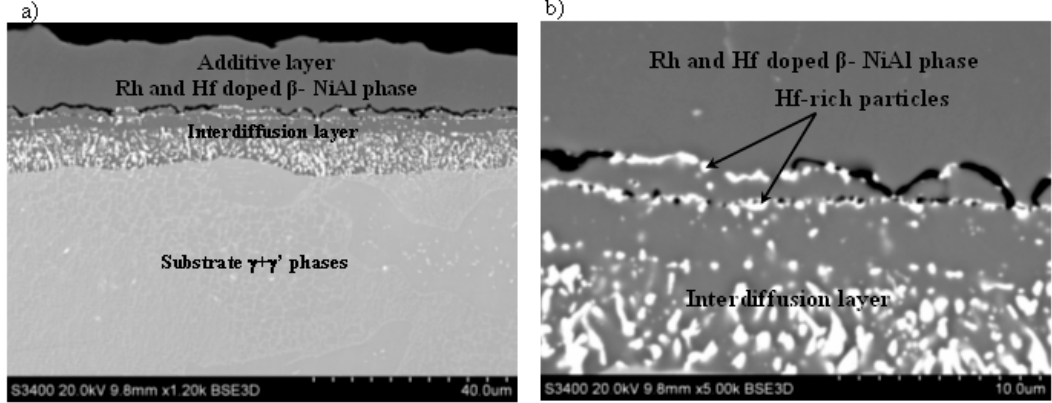
Figure 8. Microstructure on the cross-section of the rhodium- and hafnium-modified aluminide coating ( a ), hafnium-rich particles at the additive/interdiffusion layer interface ( b ). Table 2. Chemical composition of the hafnium-rich